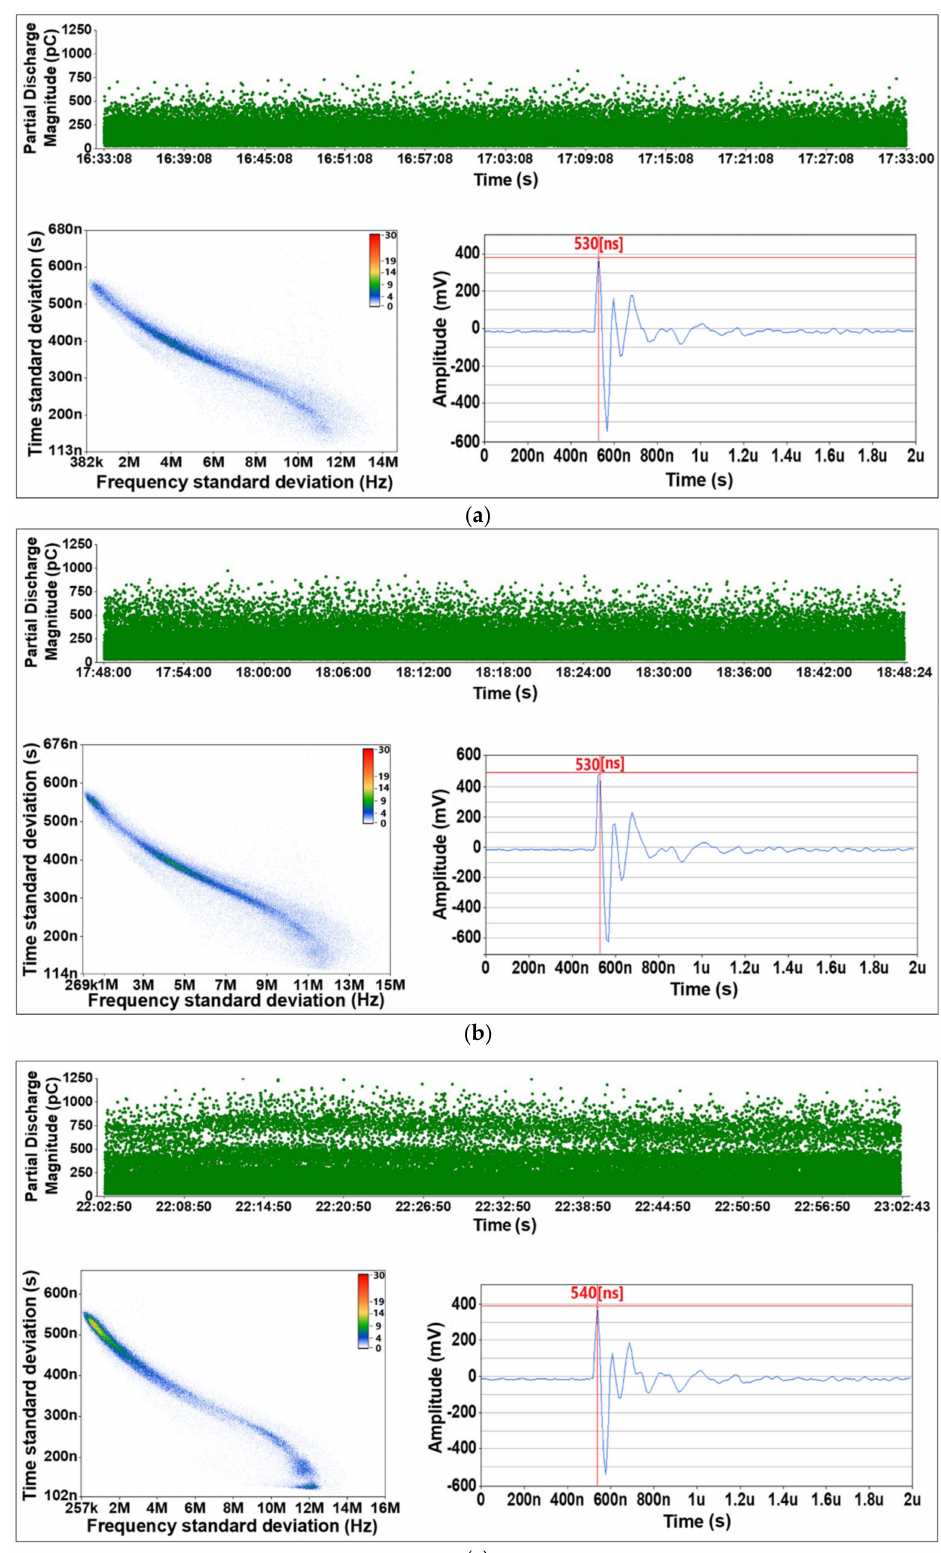
Figure 7. The measurement results of DC void discharge for an applied voltage of 35 kV, according to the specimen temperature: ( a ) 55 ◦ C; ( b ) 65 ◦ C; ( c ) 75 ◦